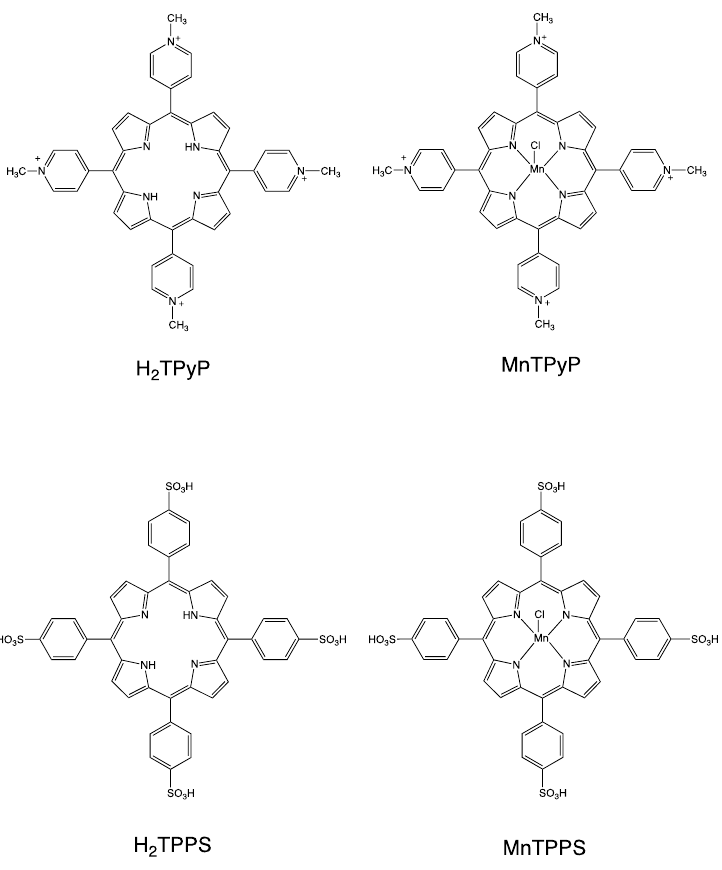
Figure 1. Molecular structure of the four studied porphyrins.